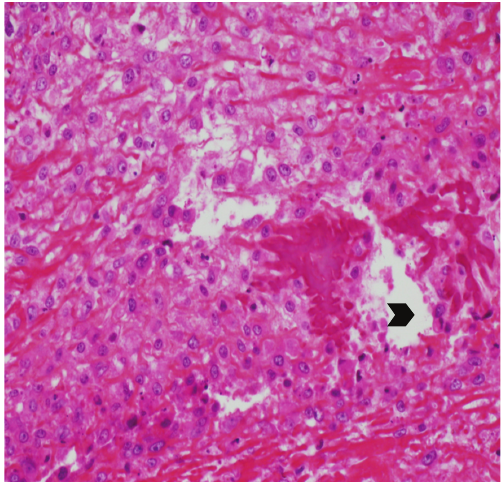
Figure 2: Histopathological examination showing osteoid (black arrow head) surrounded by multiple cellular